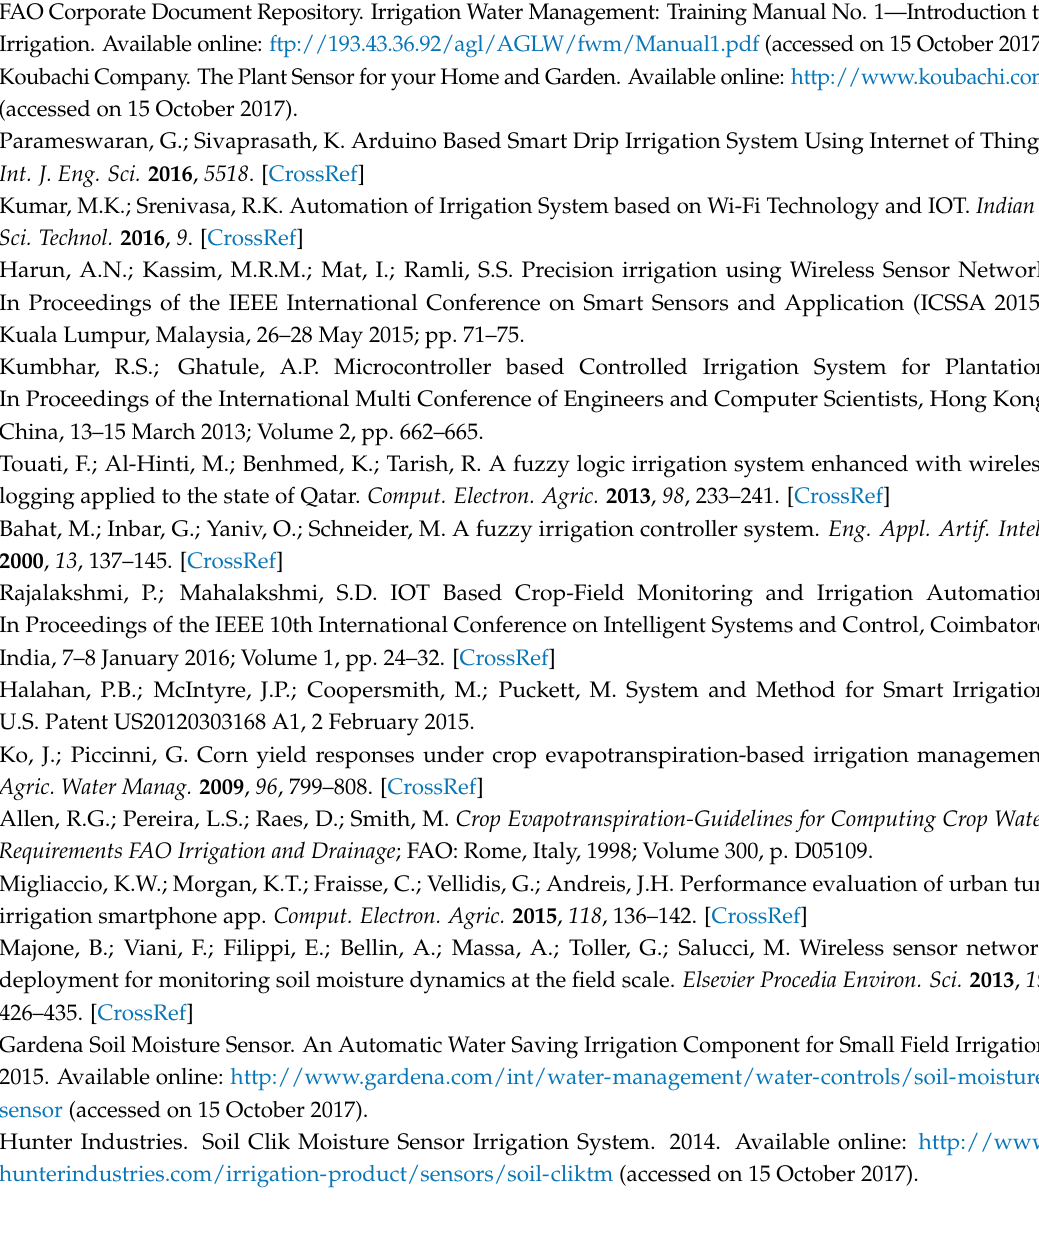
algorithm towards MVA algorithm on two nearby tomato crop fields. From the experimental results algorithm manages to save 7% of water consumption while maintaining 12.5% more ground moisture and producing 25% more monthly crop